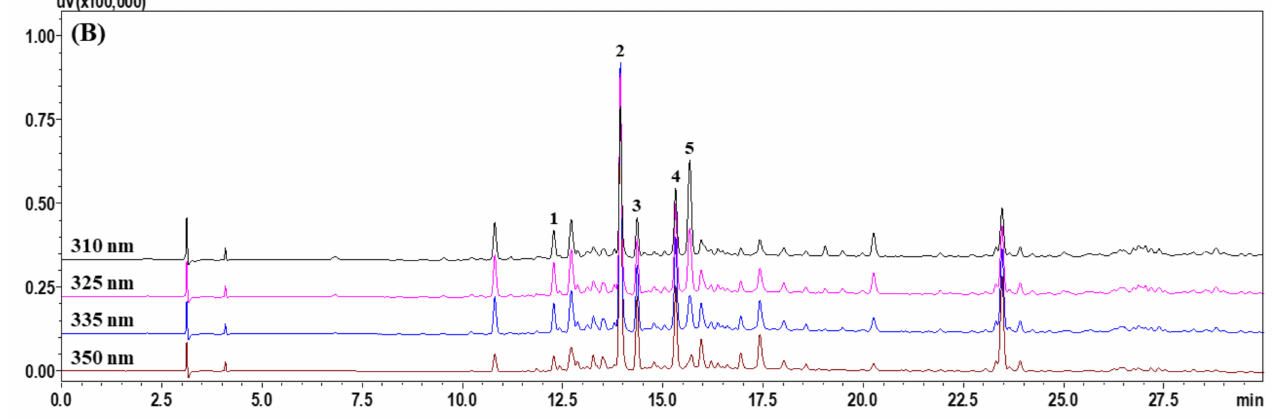
Figure 1. Representative HPLC chromatograms of ( A ) mixture of five marker standard compounds and ( B ) an extract from P. pubescens leaves. Peaks eluted in the order chlorogenic acid ( 1 ), isoori- entin ( 2 ), orientin ( 3 ), isovitexin ( 4 ), and p -coumaric acid ( 5 ) at 12.24, 13.92, 14.34, 15.30, and 15.66 min, respectively.